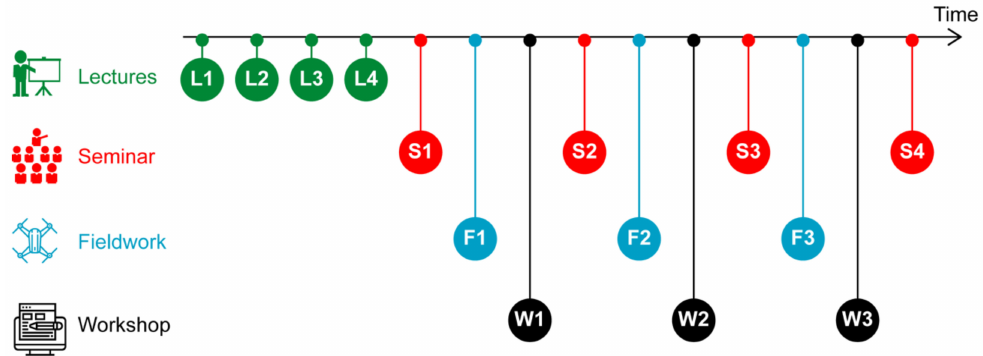
Figure 5. Temporal distribution of teacher-guided activities, lectures, seminars, fieldwork, and workshops for "UAVs in the Agroforest